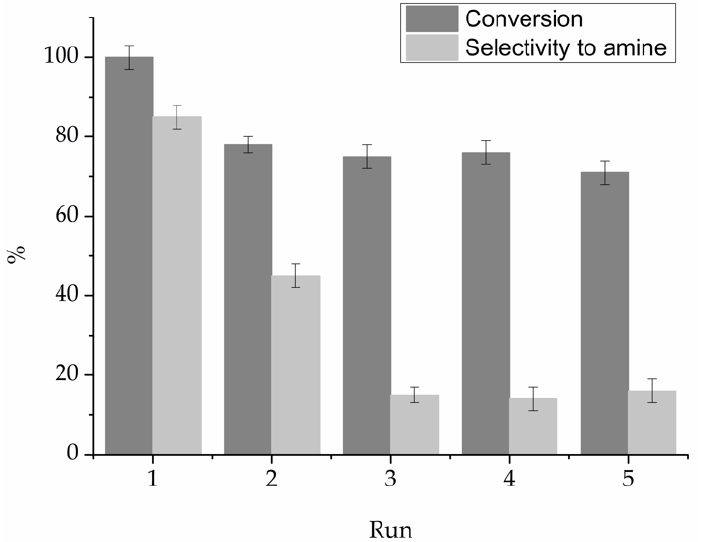
Figure 5. Benzyl alcohol conversion and selectivity to N -isopropylbenzylamine on recycling (6 h) over Au SI /NiO.